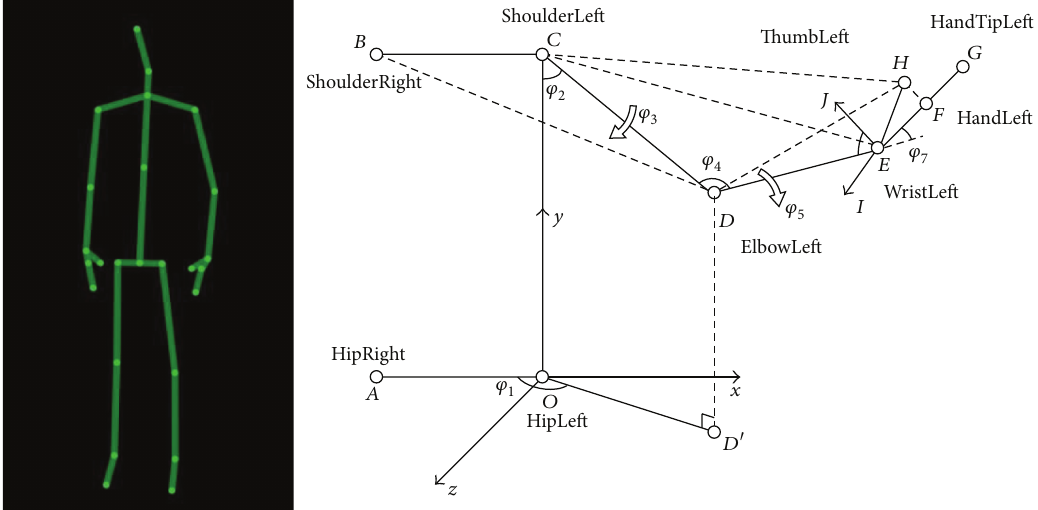
Figure 4: Body skeleton map consisting of 25 joints captured by Kinect and Human arm motion model in joint